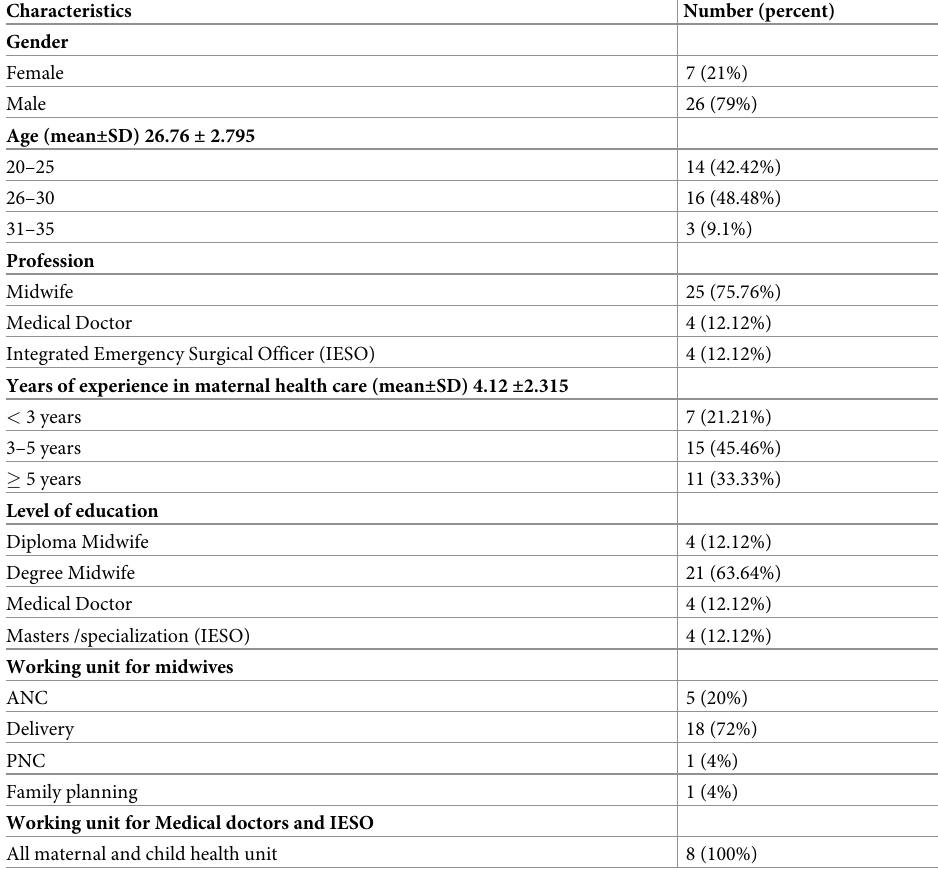
Table 1. Sociodemographic characteristics of participants at primary hospitals, north Shoa, Amhara Region, Ethi- opia, 2019 (n = 33).